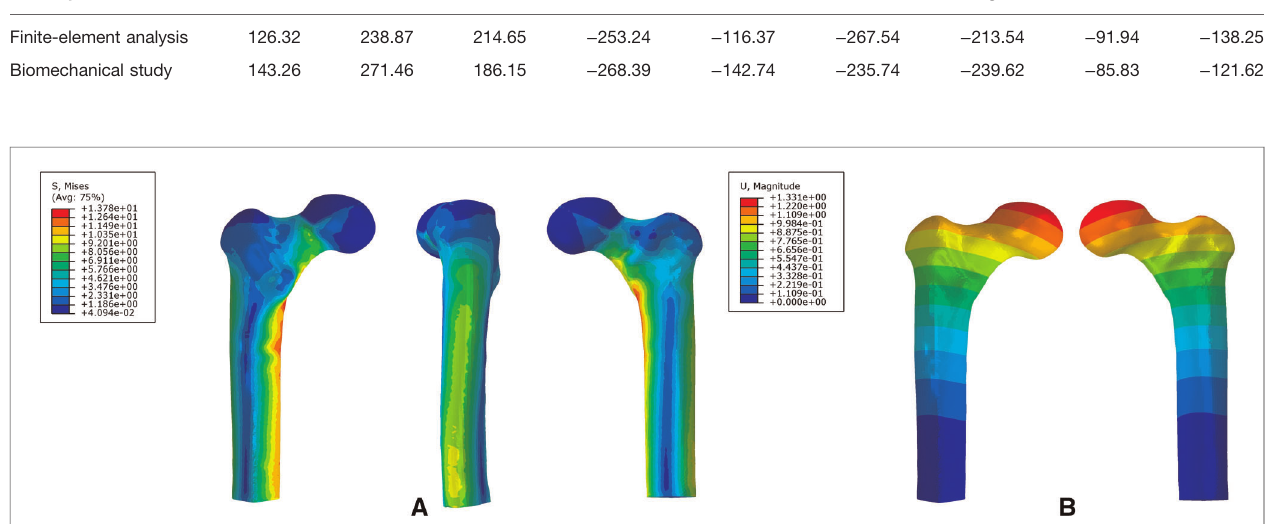
TABLE 1 | The strain values of the biomechanical test and fi nite-element analysis (10 − 6 ). Maker point i